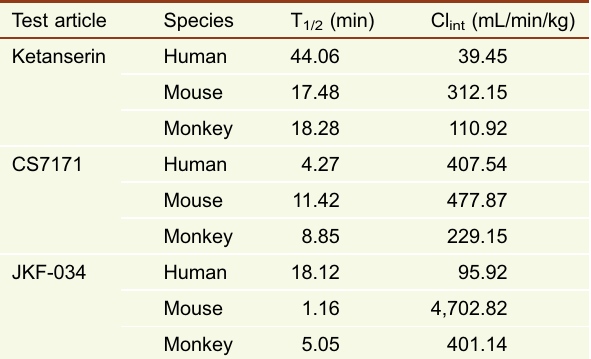
Table 4. Metabolic stability of CS7171 and JKF-034 in liver